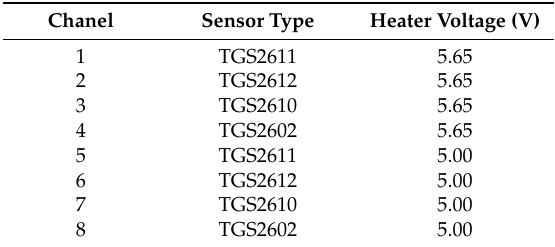
Table 2. Models and Heater Voltages of MOS sensors.